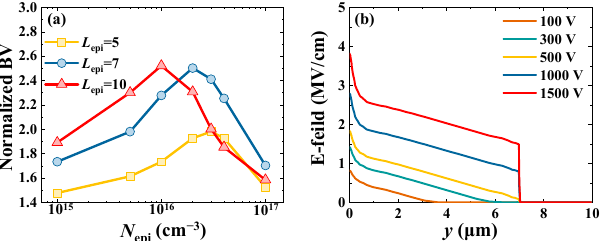
Figure 8. ( a ) The breakdown voltages increase first and then decrease. ( b ) Vertical electric field profile of a given device at different voltages.